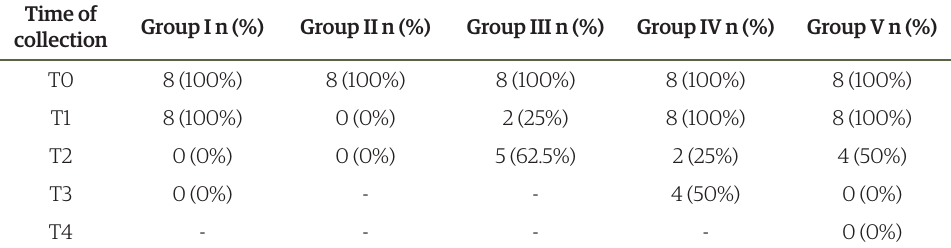
Table 1. Rate of bacterial growth of samples collected at different times.